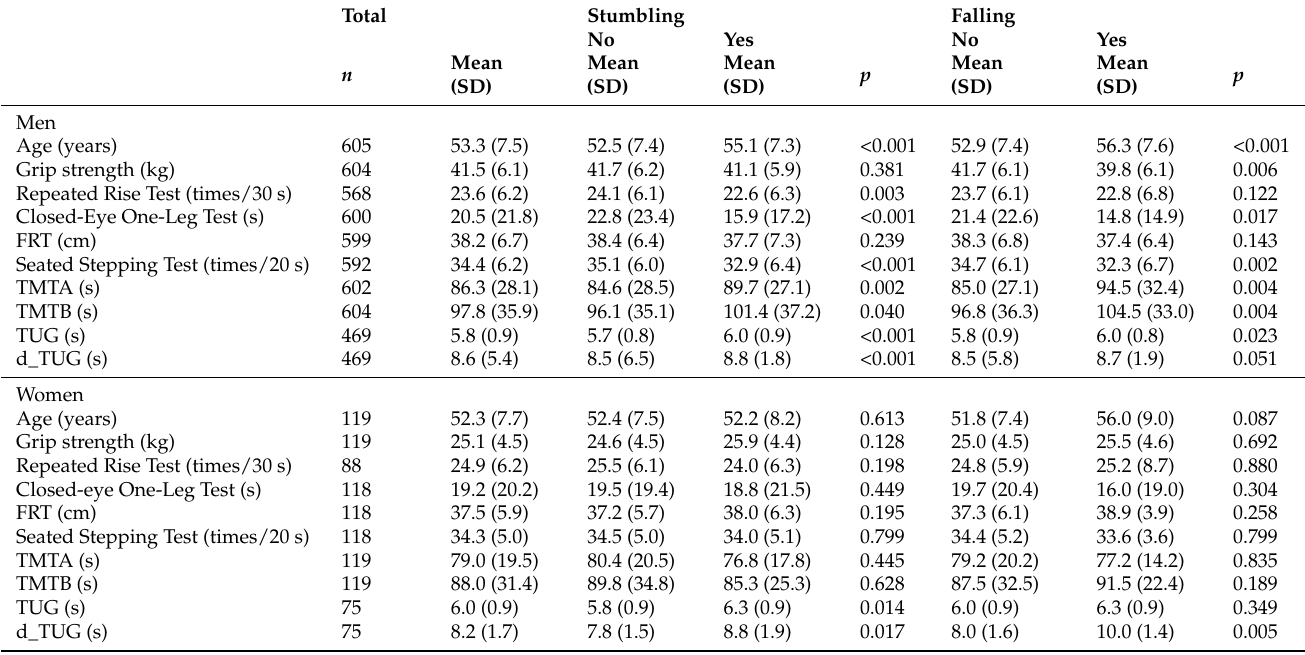
Table 3. Characteristics of continuous variables grouped according to the outcomes and sex.